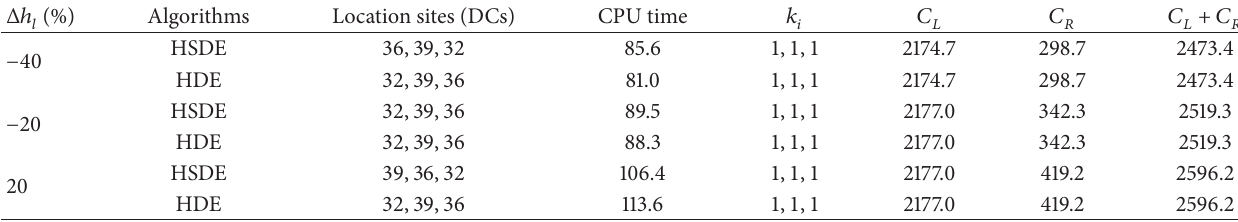
Table 7: Comparative results using three algorithms under different ℎ 𝑙 .